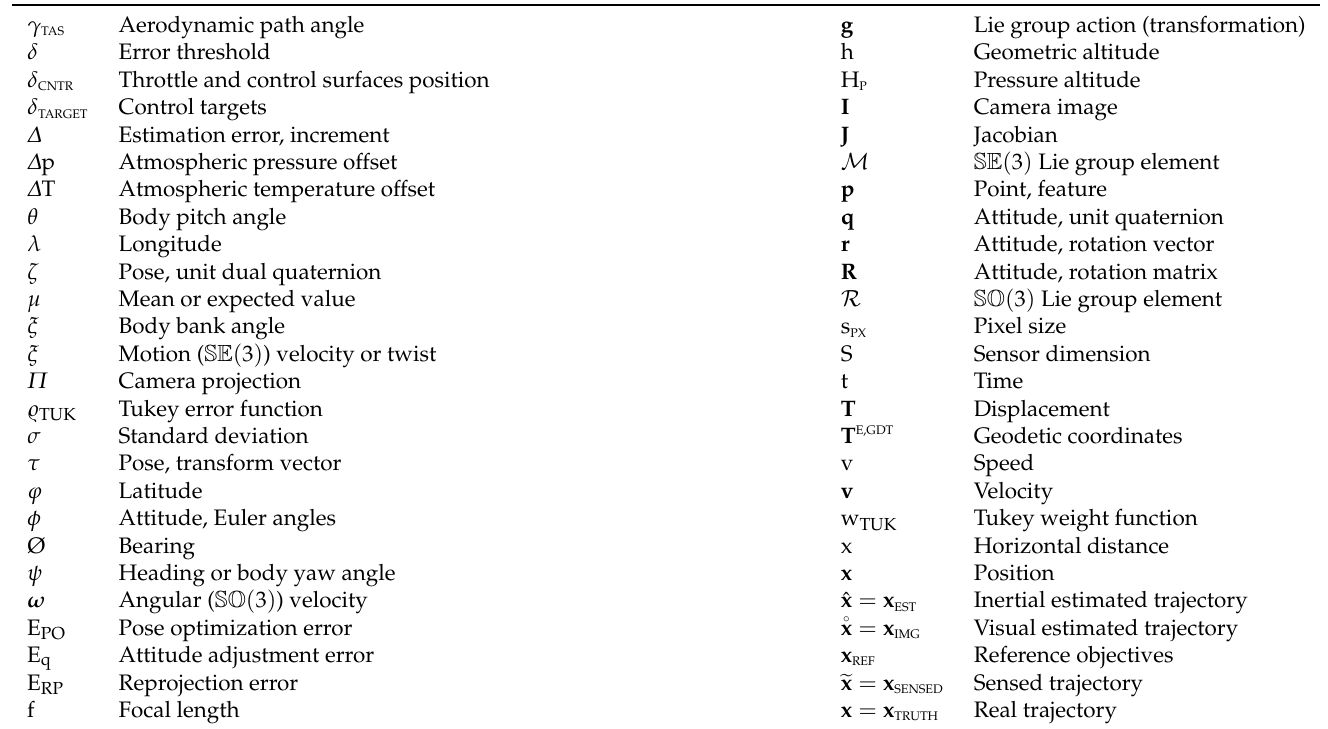
Table 1. Mathematical